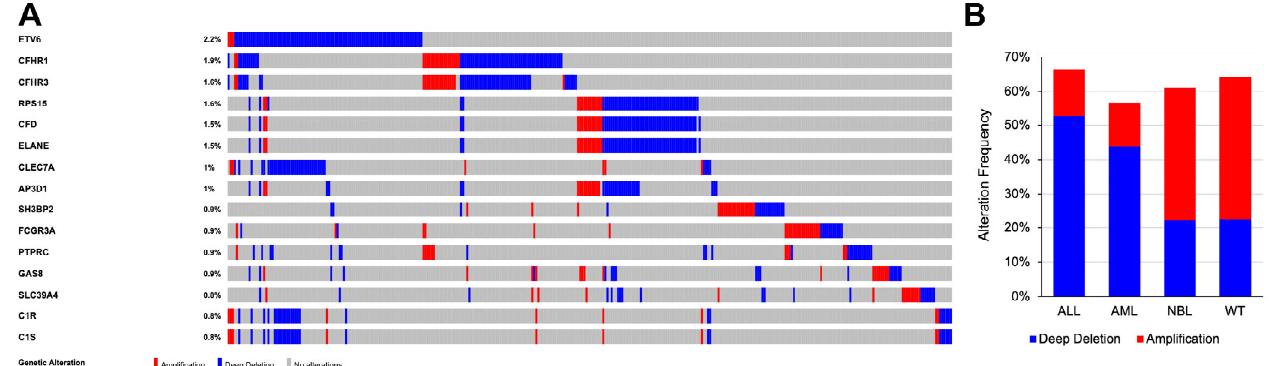
Figure 4. Copy number variation in PID ‐ related genes among pediatric cancer patients. ( A ) Oncoprint depicting the major copy number alterations observed in pediatric ALL, AML, NBL, and WT samples. ( B ) Overall copy number alteration frequencies of PID ‐ related genes with amplification and deletion status in each pediatric cancer cohort. Data were obtained from TARGET datasets on cBioPortal (v3.7.20).